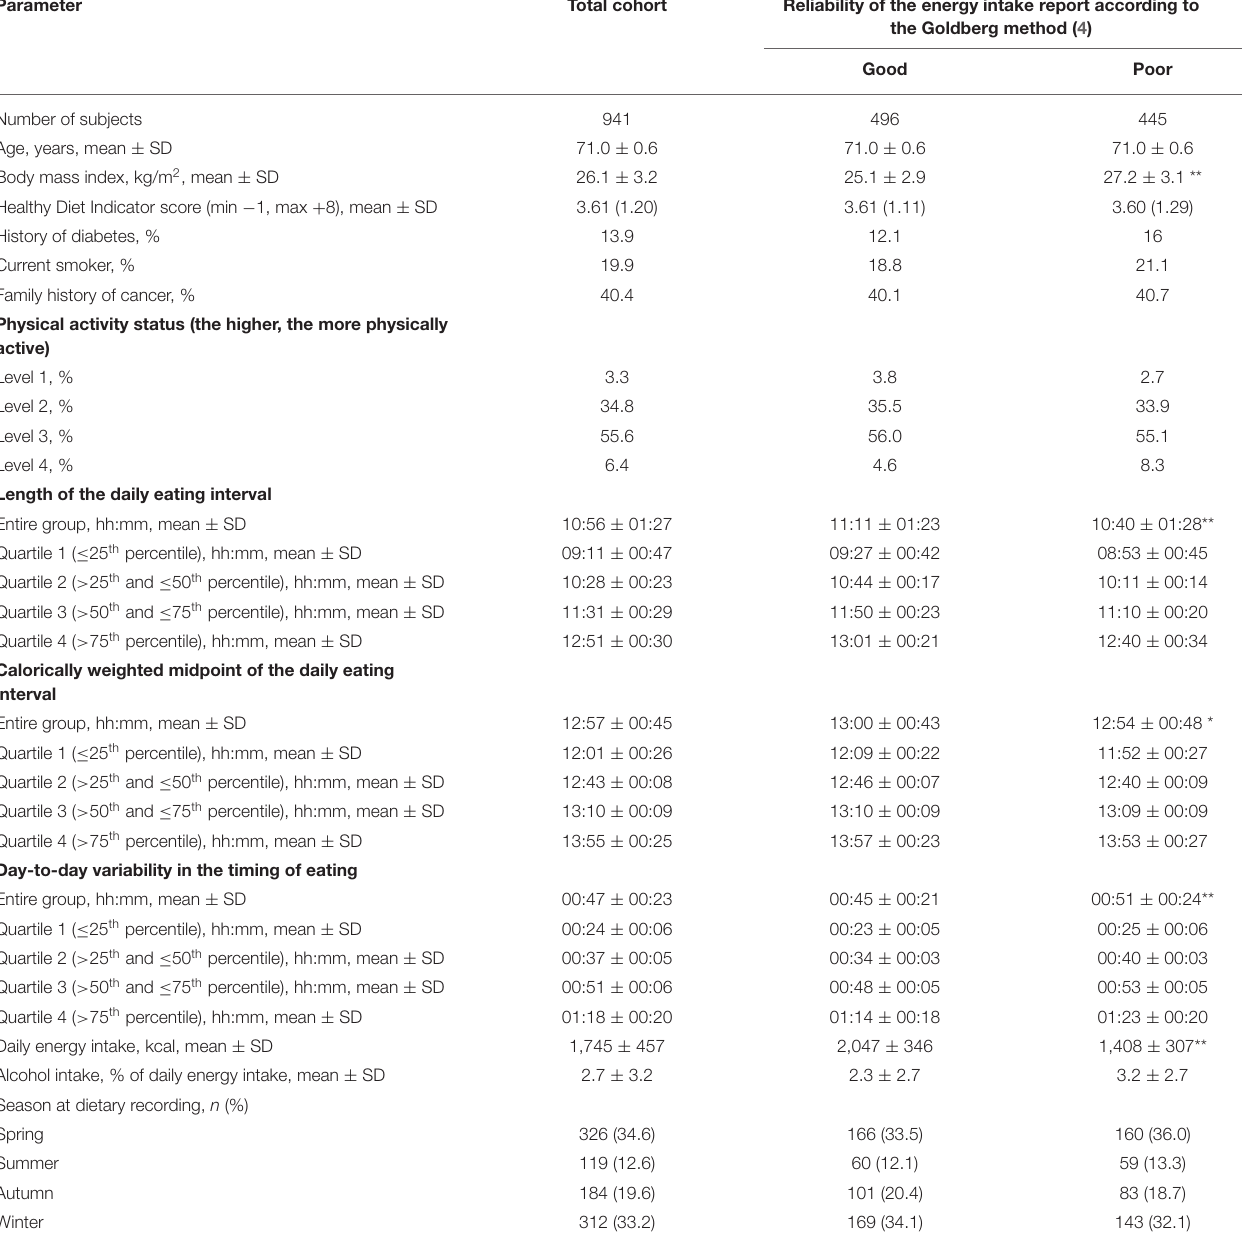
the Goldberg method (4) Good Poor